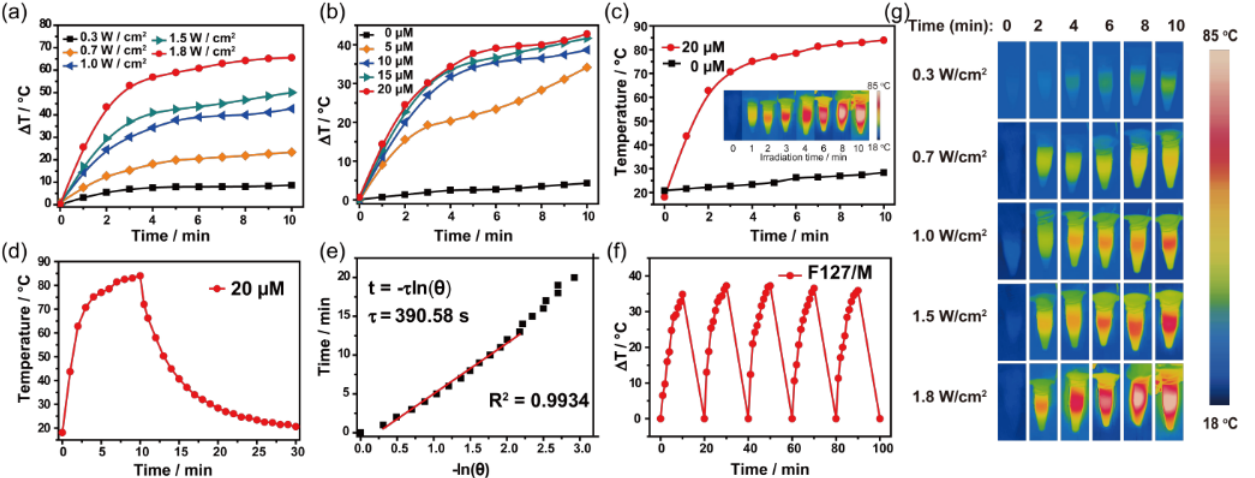
Figure 3. ( a ) Photothermal conversion of F127/ M NPs (20 μ M) under laser irradiation at different power densities (660 nm, 0.3–1.8 W/cm 2 ). ( b ) Photothermal conversion of F127/ M NPs at different concentrations (5 − 20 μ M) under laser irradiation (660 nm, 1.0 W/cm 2 ). ( c ) Photothermal conversion of F127/ M NPs at different concentrations (0 and 20 μ M) under laser irradiation (660 nm, 1.0 W/cm 2 ). Insert: IR thermal images of F127/ M NPs. ( d ) Photothermal heating curves of F127/ M NPs under irradiation (660 nm, 1.8 W/cm 2 ) for 10 min and subsequent natural cooling. ( e ) Time constants for calculation of the PCE by applying the linear time data from the cooling period to the negative natural logarithm of temperature. ( f ) Photothermal stability of F127/ M NPs under laser irradiation (660 nm, 1.0 W/cm 2 ) over five heating/cooling cycles. ( g ) IR thermal images of F127/ M NPs following irradiation at different laser power densities (660 nm, 0.3 − 1.8 W/cm 2 ).